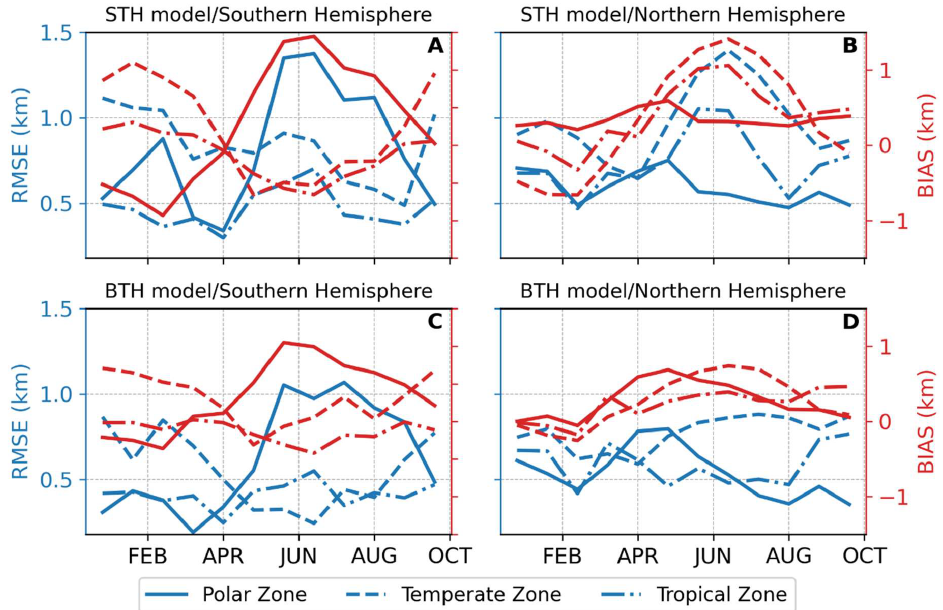
Figure 7. Root-mean-square error (models vs. radiosondes data) by climate regions, polar (90°–60°), temperate (60°–30°), and tropical zones (30°–0°) for both hemispheres in the validation period 2018– 2020. Panel ( A , B ): STH model for SH and NH hemisphere, respectively; Panel ( C , D ): BTH model for SH and NH hemispheres, respectively. The red lines identify the bias. A positive bias indicates a model overestimation.